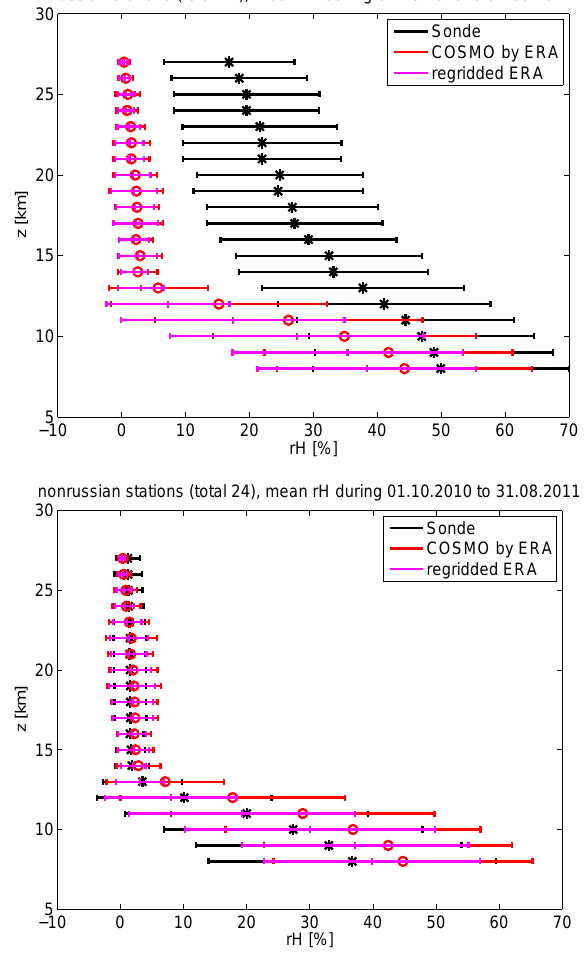
Figure 11. Mean relative humidity values of Gomel (BY) and the 23 Russian stations (top), and 24 stations outside of Russia but in the eastern part of the domain (bottom). The horizontal lines give the 1 σ standard